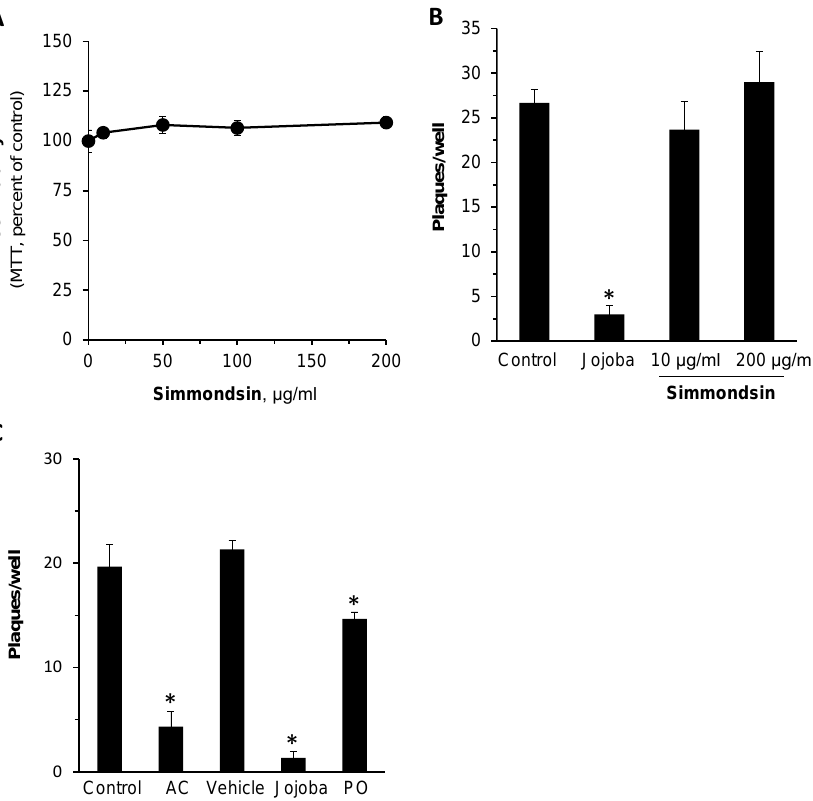
Figure 3. The impact of simmondsin on HSV-1 infection. Vero cells were treated with or without increasing concentrations of Simmondsin for 96 hr. Then, cell viability was determined by the MTT assay ( A ). The impact of Simmondsin on HSV-1 infected Vero cells in comparison to Jojoba wax (JD-4; 8 µg/mL) is presented ( B ). A similar test was performed to compare the anti-viral action of Jojoba to 8 µg/mL PA ( C ). Mean ± SEM; n = 3; * p < 0.05 in comparison to the infected control. AC-acyclovir; PO–petroleum oil.